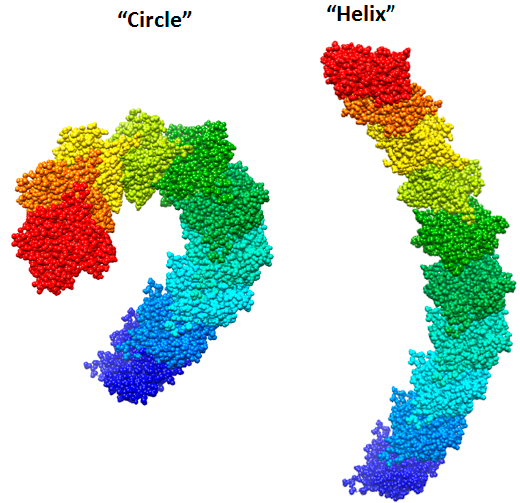
Figure 7. New F ‐ actin models: “circle” and “helix”. Each of these models consists of 10 actin monomers. The PDB structure (2zwh) was taken as a building unit.